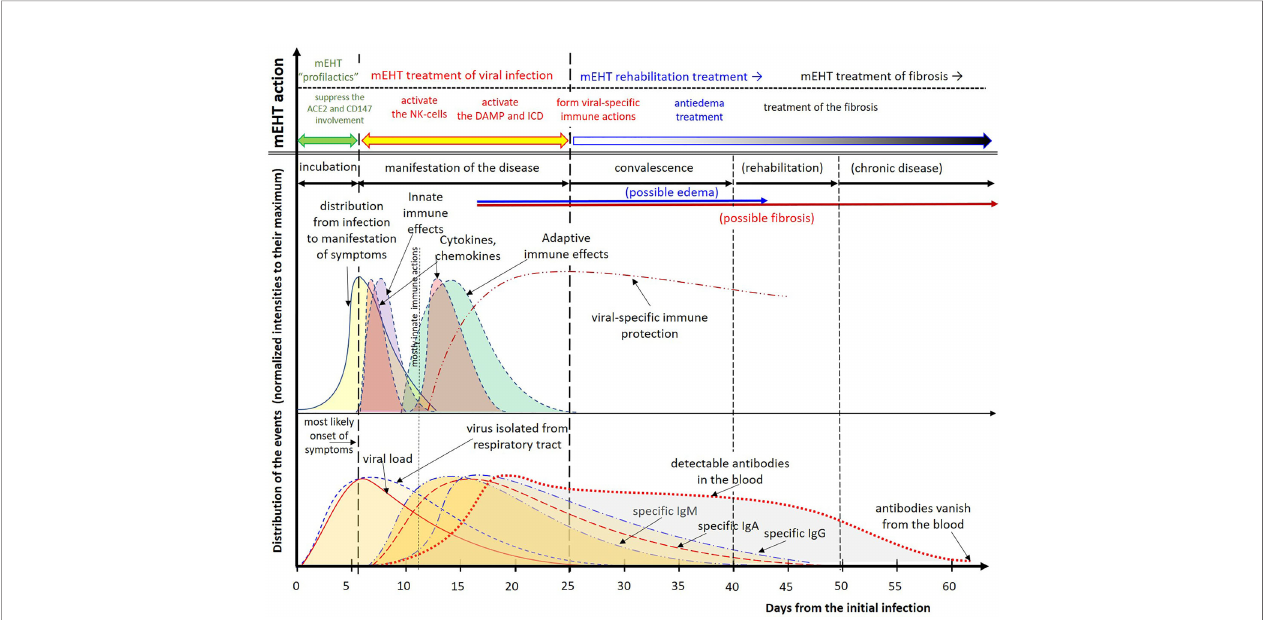
FIGURE 7 | Summary of the viral effects of SARS-CoV-2 and the hypothesis based proposal for treatment. Due to the considerable individual differences, the distributions are normalized to their maximum. The intervals are approximate. The distributions are composed to their most likely form using the results (71, 107, 162 – 169). The disappearance of antibodies to SARS-CoV-2 was measured too (170), but others measured the opposite, existing antibody protection at least for two years